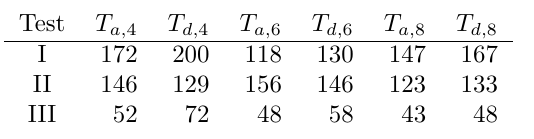
Table 11: Measured rise times (63%, in ms) for the dif- ferent test cases and number of propellers.